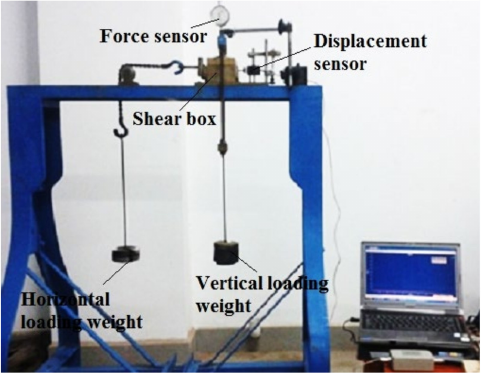
Figure 2. Direct shear creep apparatus of deep-sea simulant sediment.